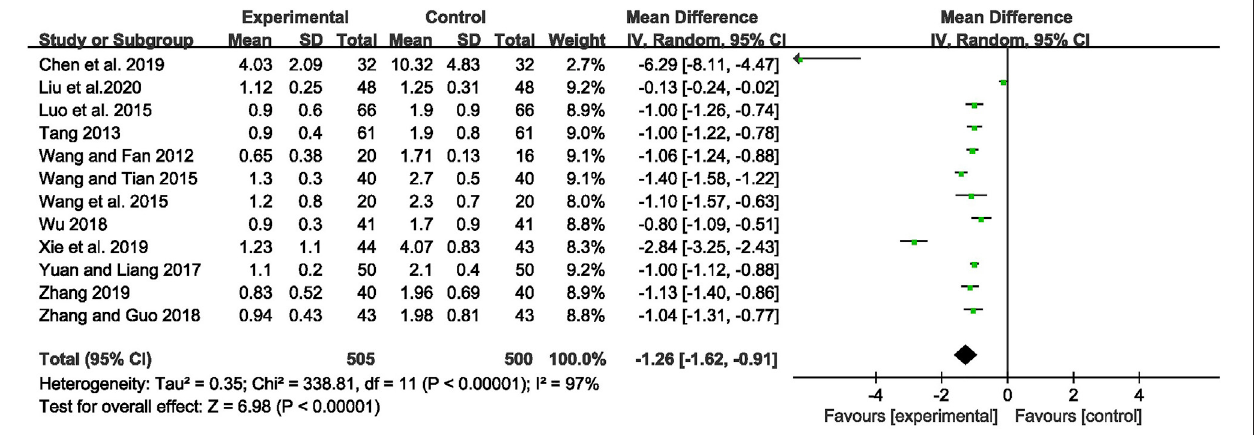
Frontiers in Pharmacology |